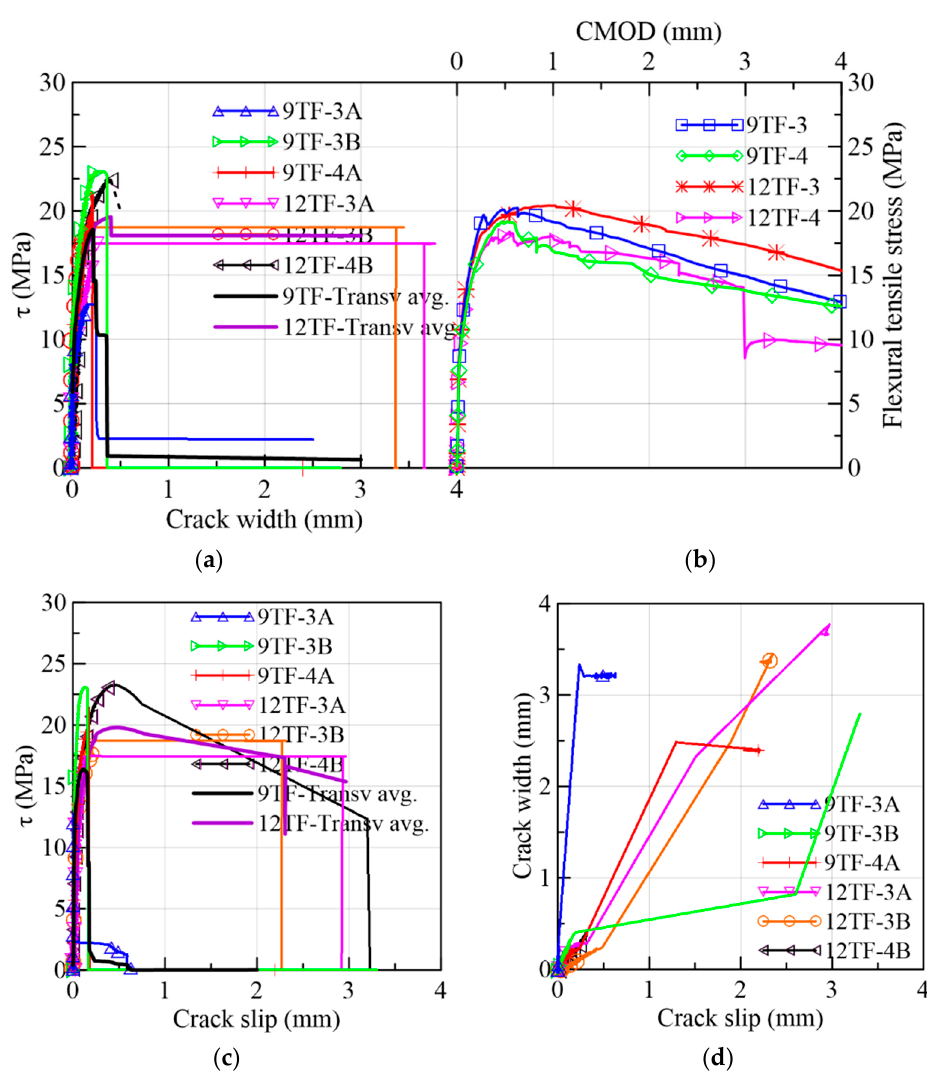
Figure 17. Mechanical results of 9TF-12TF specimens of the transverse direction: ( a ) shear stress vs. crack width; ( b ) flexural tensile stress vs. CMOD; ( c ) shear stress vs. slip; ( d ) crack width vs. slip.